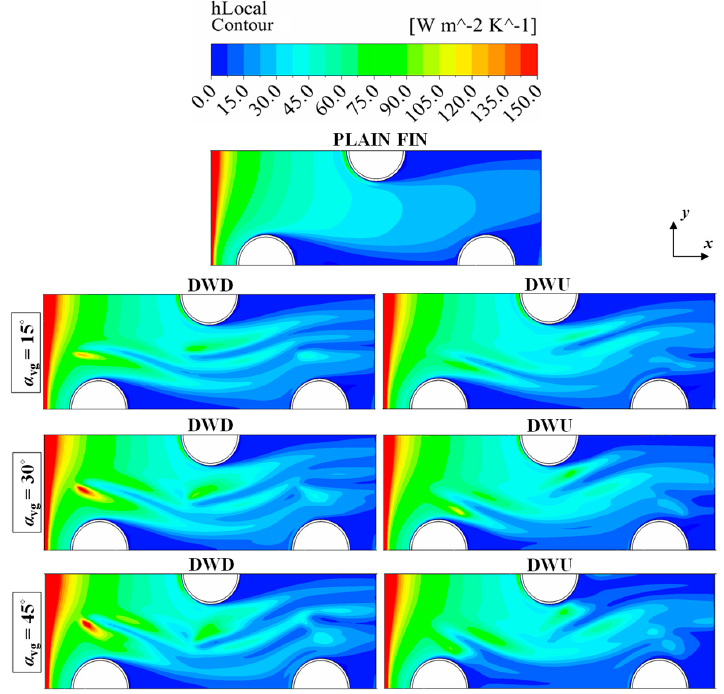
Figure 16. Distributions of the local air − side heat transfer coefficients on the plain fin surface and upper fin surface without mounted vortex generators for air − to − water FTHEXs with DWD and DWU configurations. Test conditions: T air,in = 22 °C, T water,in = 40 °C, w air,in = 1.03 m/s, w water,in = 0.76 m/s.